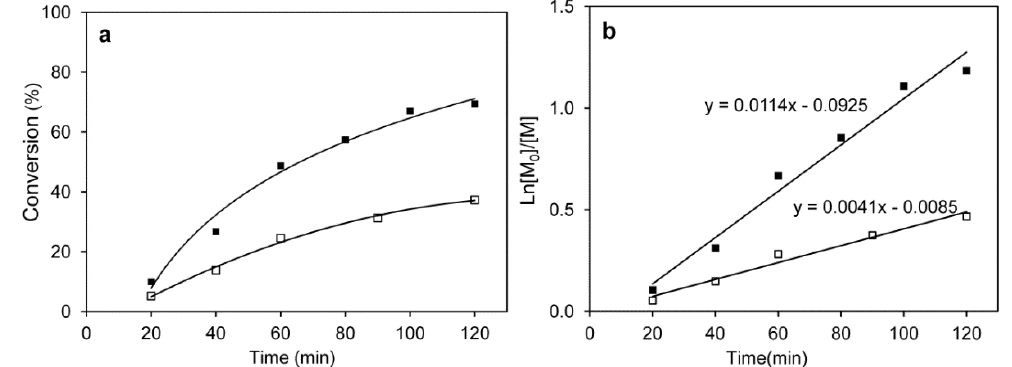
Figure 2. ( a ) Conversion as a function of time for ( ■ ) DEGMA and ( □ ) OEGMA using THF as solvent at 25 ( v / v , %) and M:CTA:I = 500:4:1 mole ratio and ( b ) pseudo-first order kinetic plot for ( ■ ) DEGMA ( R 2 = 0.9915) and (□) OEGMA ( R 2 = 0.9745).